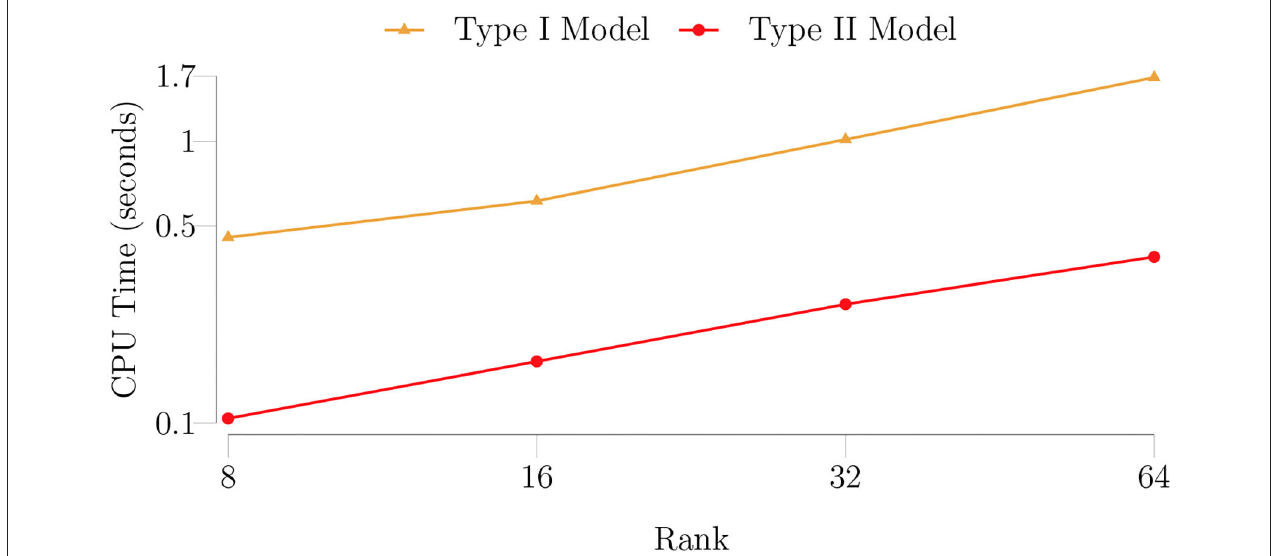
FIGURE 5 | The median CPU time (seconds) per epoch for the type I and type II model as a function of the rank for a rank-8 function given as in Equation (28) for 100 trials. The number of samples for the training dataset is set to 5,000 and for the test dataset it is set to 1,000. The batch size is set to 500 and the maximum number of GN iterations is set to 5. The figure confirms that the computational complexity of the type I model is d times the computational complexity of the type II model (cf. Section 3.5). Moreover, the computational complexity of the algorithm is linear in the rank (cf. Section 3.5). The figure is in a logarithmic scale on the horizontal